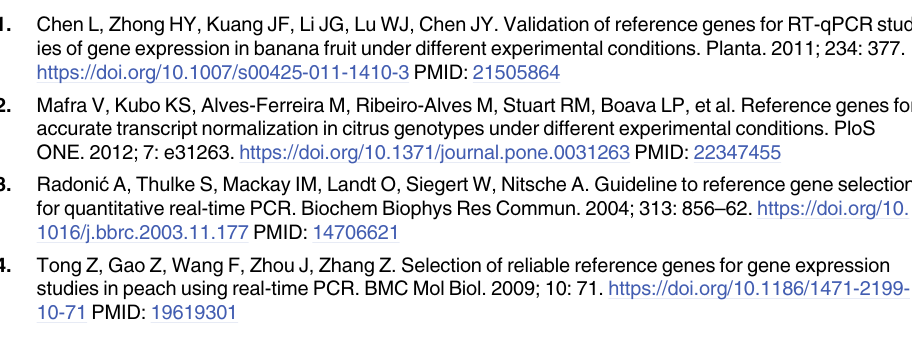
S4 Table. Primer pairs for reference genes and endocarp varying genes. S5 Table. Reference candidate gene descriptions. S6 Table. Peach and Apple orthologs. S7 Table. Coefficient of variance for RNAseq experiments in early Peach and Apple fruit for the nine candidate reference